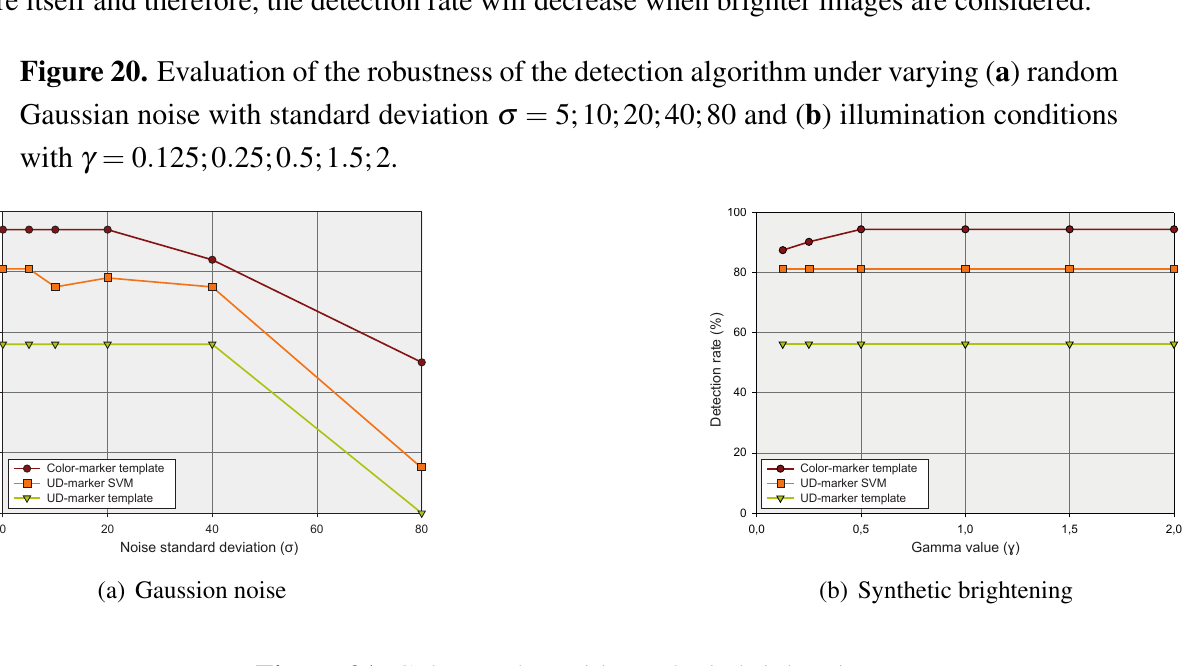
Figure 21. Color marker with synthetic brightening.